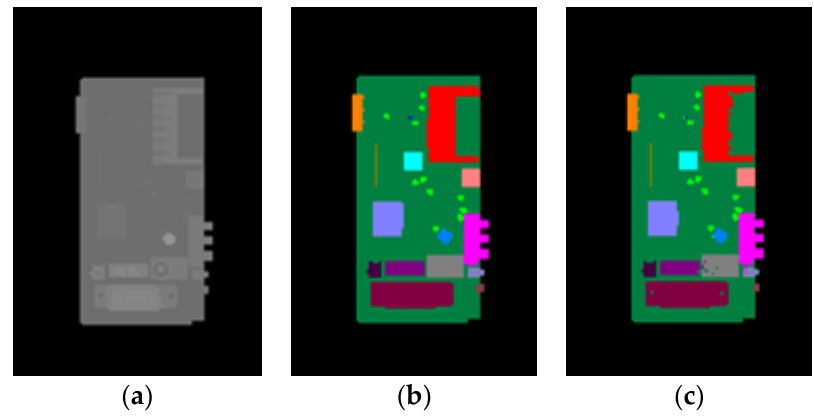
Figure 14. The results of our method for a television motherboard. ( a ) Synthetic depth image. ( b ) Color-labeled image. ( c ) The resulting pixel classification image of ( a ).